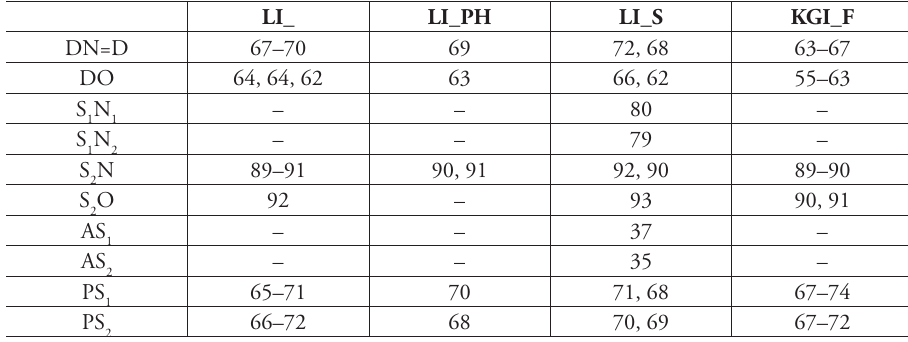
Table 4. Pharyngeal characters of Enchodeloides signyensis gen. n., comb. n. For abbreviations see Loof & Coomans (1970) and Andrássy, 1998b.